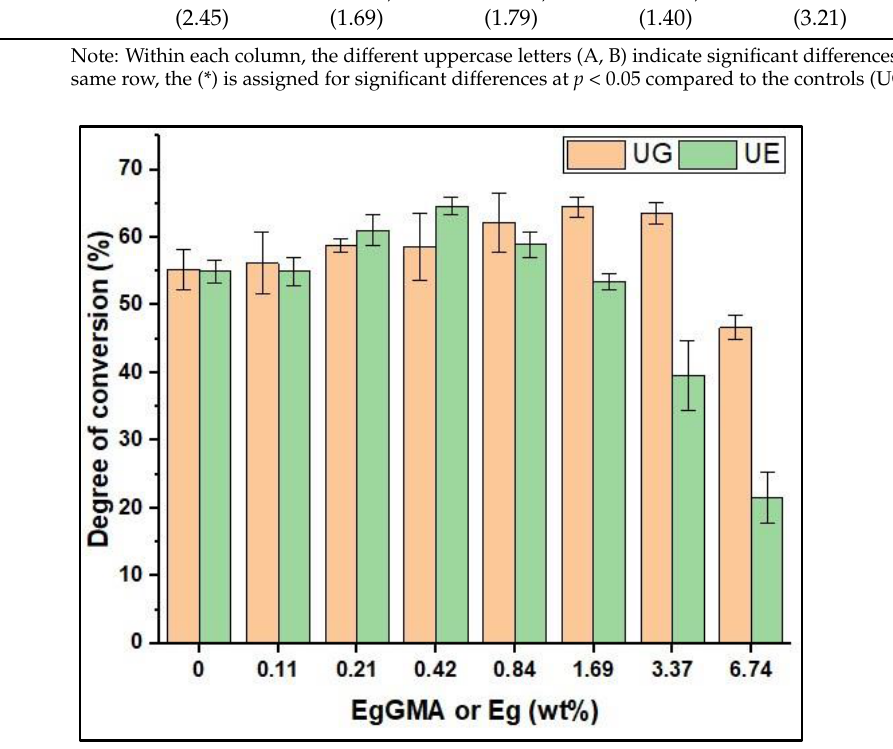
Figure 5. Degree of conversion (DC) of investigated composites: UG0–UG6.8 and UE0–UE6.8 groups. Bars are for standard deviations of five replicates ( n = 5) per composite. UG is urethan dimethacrylate (UDMA)-eugenyl glycidyl methacrylate (EgGMA), UE is UDMA-eugenol (Eg), and numbers indicate the weight percent fraction of EgGMA or Eg (0–6.8 wt%) in the